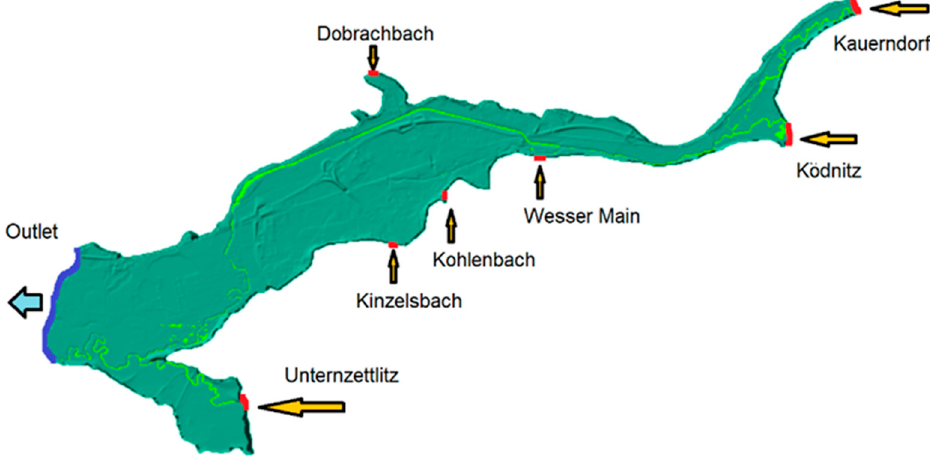
Figure 2. Model grid area with marked Inflows(red) and outflows (blue) boundary conditions.